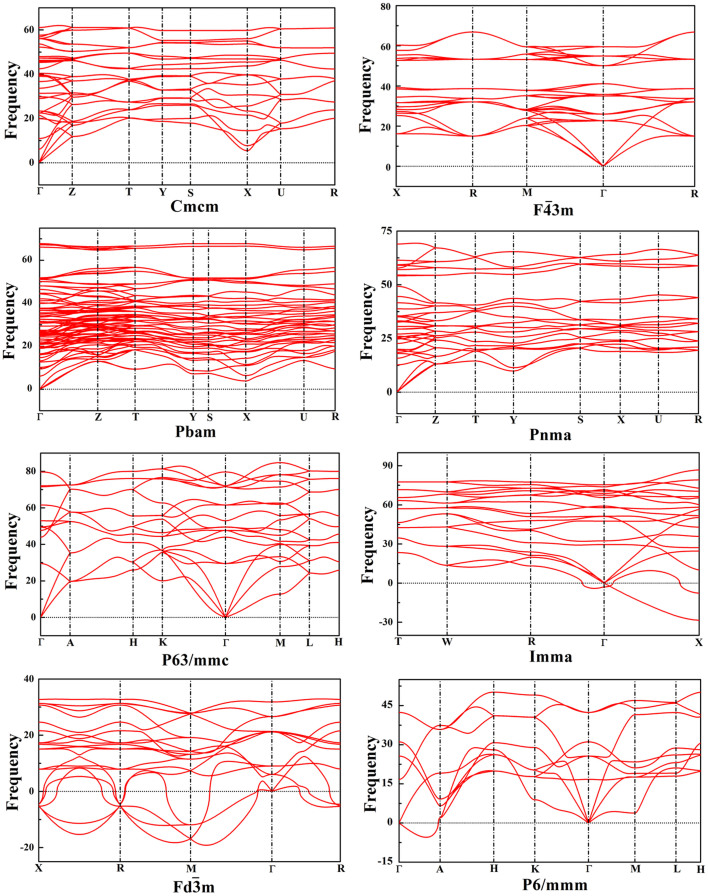
Phonon dispersion curves of available BeB2 phases.